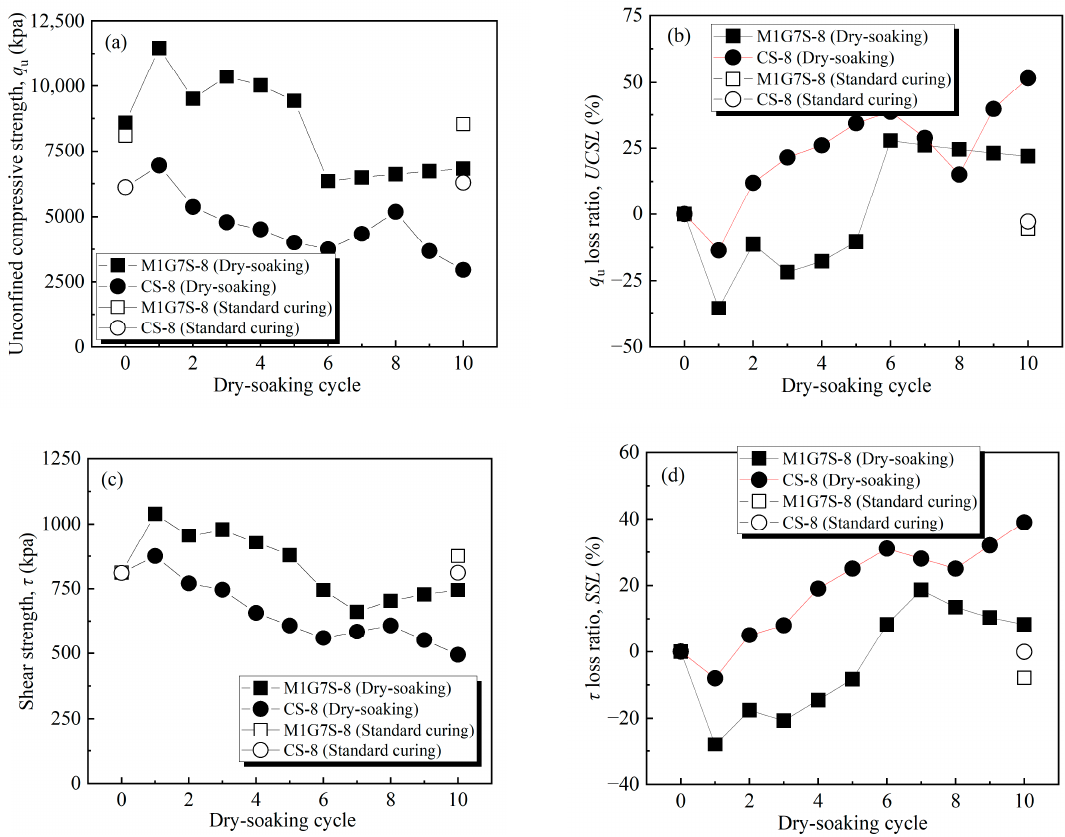
Figure 10. Variations of ( a ) unconfined compressive strength ( q u ); ( b ) unconfined compressive strength loss ratio ( UCSLi ); ( c ) shear strength ( τ ); and ( d ) shear strength loss ratio ( SSL i ) with dry– soaking cycle for shield residues stabilized by M1G7-8 and CS-8.